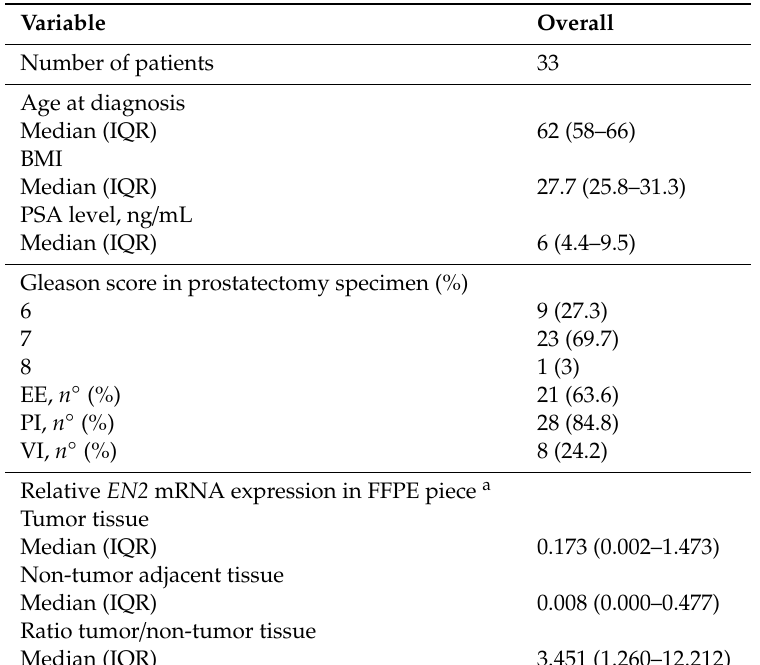
Table 1. Overall clinical and demographic data and expression levels measured in